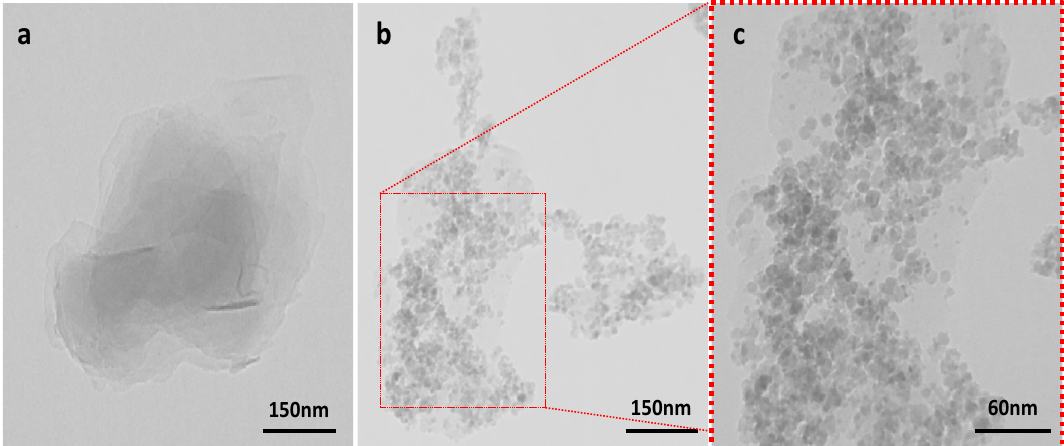
Figure 4. TEM images of ( a ) SGCN and ( b , c ) SGCN/Fe 3 O 4 /PVIs/Pd